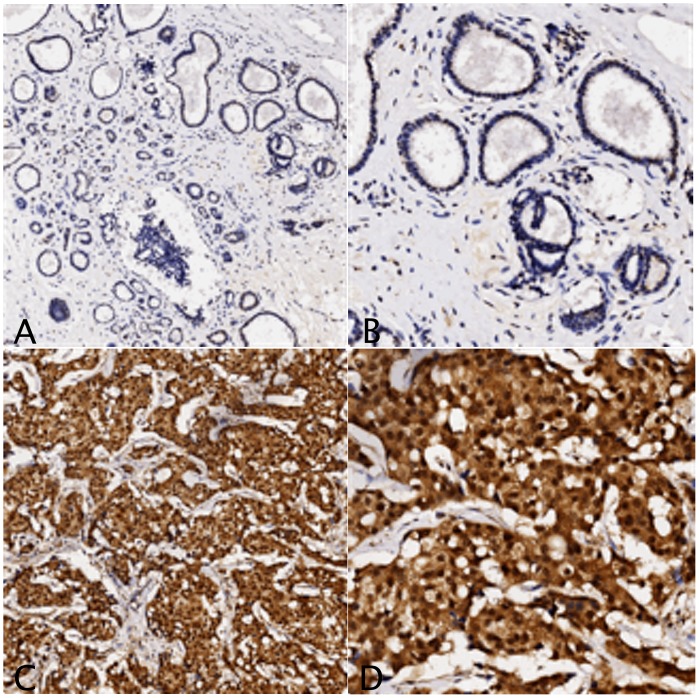
Representative results of RAD51 protein expression by immunohistochemical analysis.Percentage of positive cells and staining intensity are much lower in adjacent non-cancerous tissue (A.×40; B.×200) than in breast cancer (C.×40; D.×200).